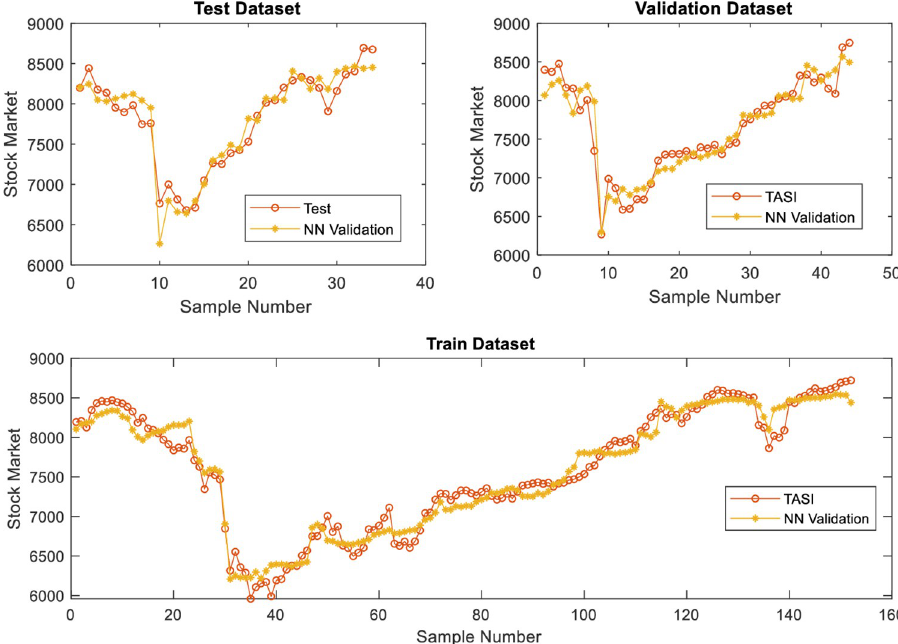
Fig 4. Performance analysis of neural network based on the validation dataset.